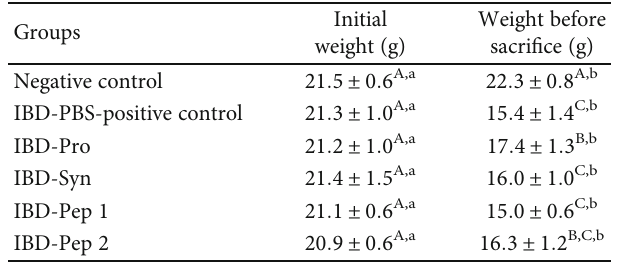
Table 4: Weight change by dextran sulfate sodium autogenous feeding.